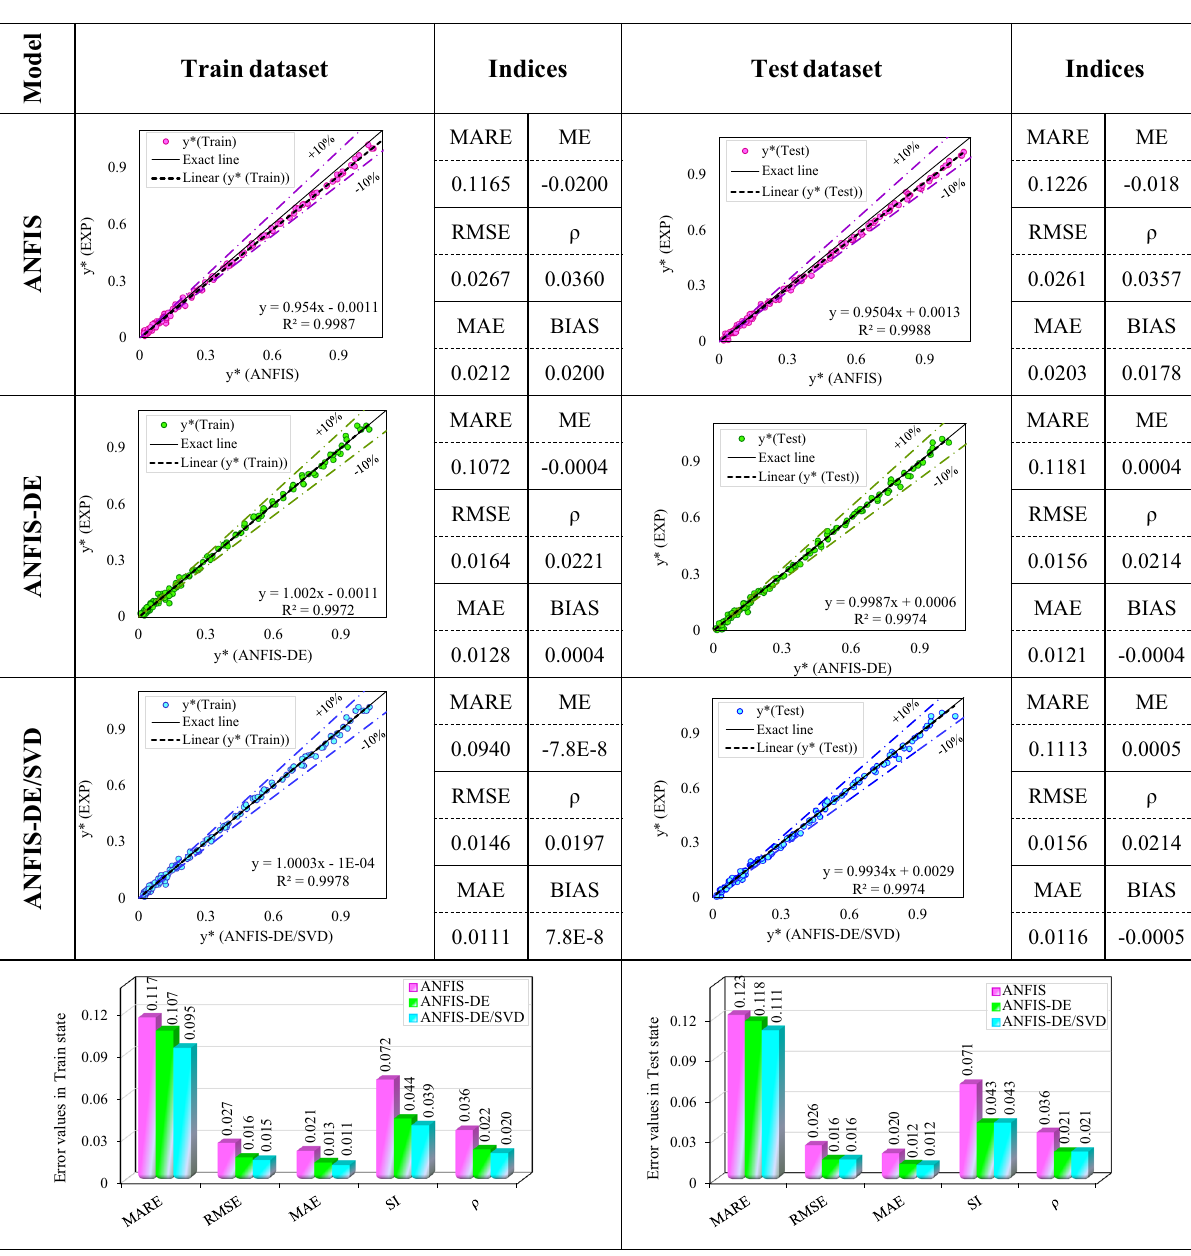
Fig. 7 Scatter plots of the y * value predicted by the ANFIS, ANFIS-DE and ANFIS-DE/SVD models compared to the corresponding laboratory values and error index bar